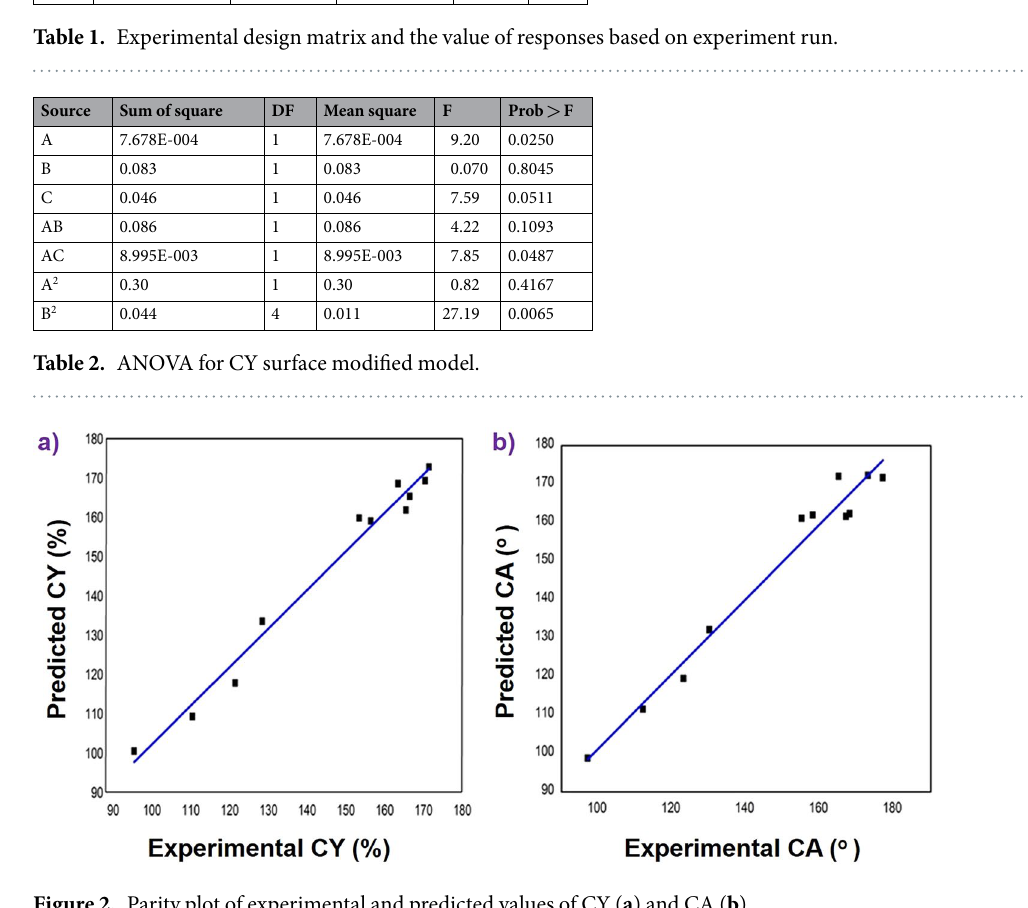
Figure 2. Parity plot of experimental and predicted values of CY ( a ) and CA ( b